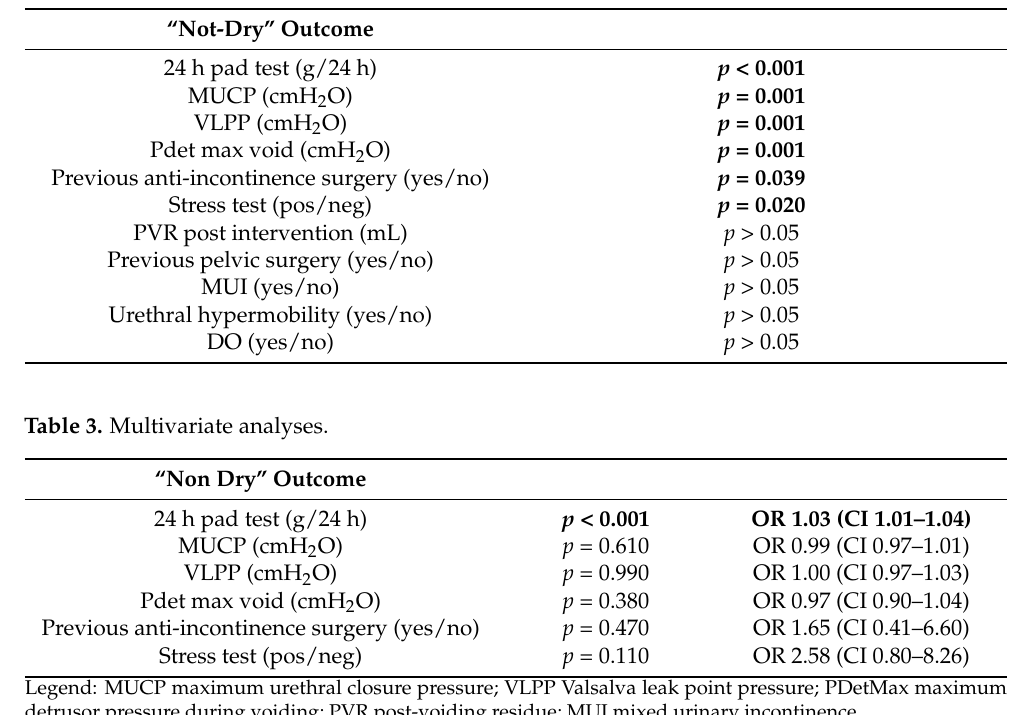
Table 2. Univariate analysis.